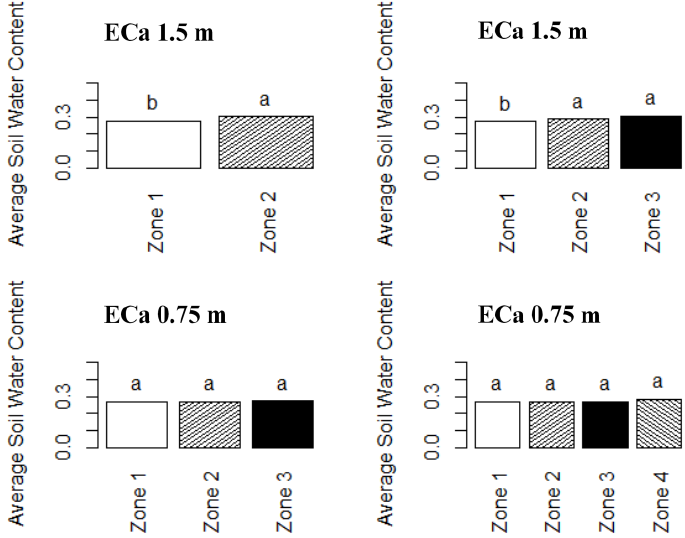
Figure 2. Mean soil water content across apparent electrical conductivity derive management zones for ARDEC. Different letters are significantly different ( p -value < 0.05).